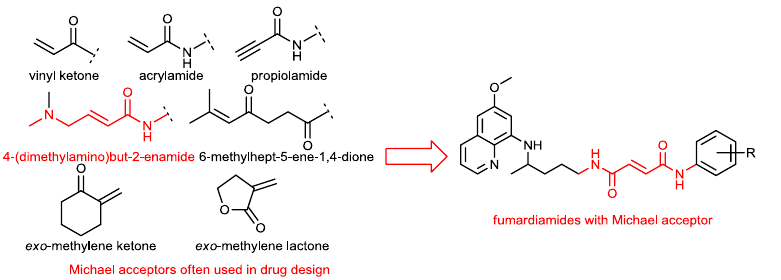
Figure 1. Design of novel fumardiamides.